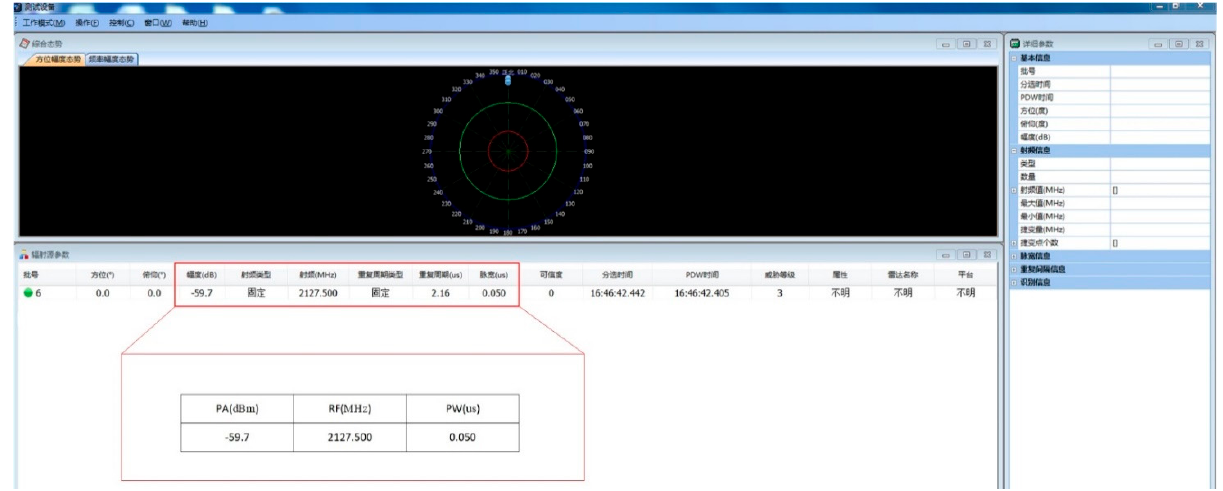
Figure 15. Sorting result diagram of the signal not designed using the anti-clustering signal design method proposed in this paper.